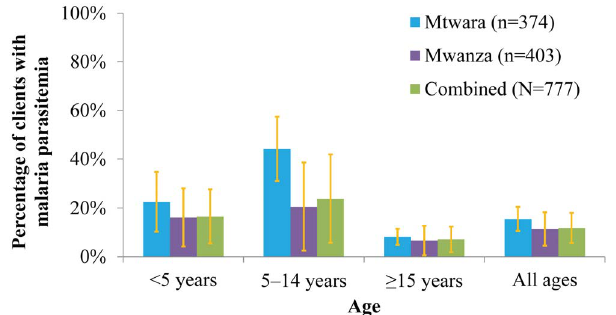
Figure 5. ACT Purchase Among Clients with Malaria Parasit- emia Stratified by Age and Region. *Proportions differed significantly between